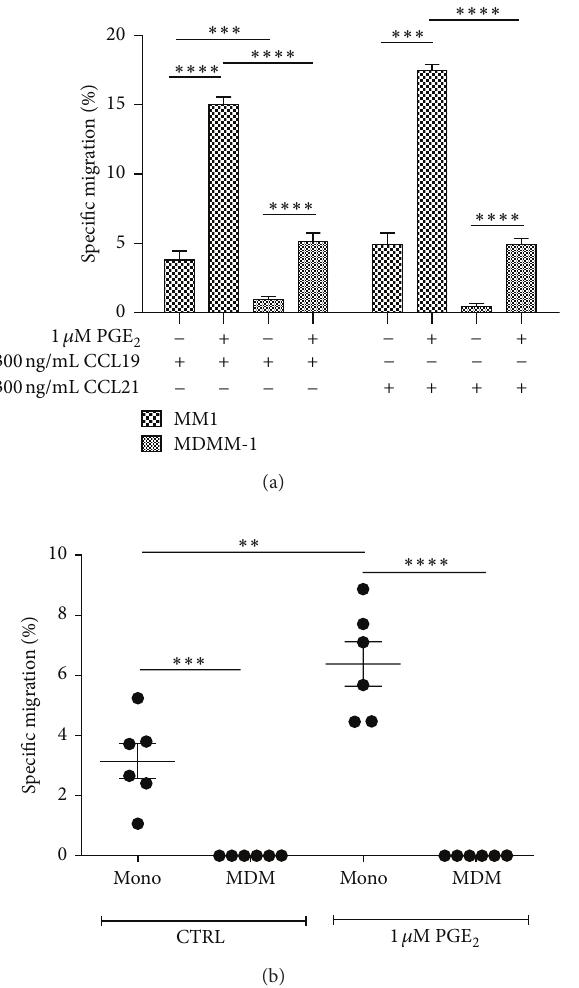
Figure 7: MDMM-1 cells and MDMs do not migrate toward the CCR7-specific ligands CCL19 and CCL21. (a) Chemotaxis assays using300ng/mLCCL19andCCL21wereperformedusingMM1and MDMM-1 cells incubated in the presence or absence of 1 𝜇 M PGE 2 for 24h. Data represent the means of three different experiments. (b) Blood monocytes from five different healthy donors were differ- entiated into MDMs and used for chemotaxis assays as described. The mean number of spontaneously migrated cells was subtracted from the number of cells that migrated in response to chemokines. ∗∗ 𝑃 < 0.01 , ∗∗∗ 𝑃 < 0.001 , and ∗∗∗∗ 𝑃 < 0.0001 .